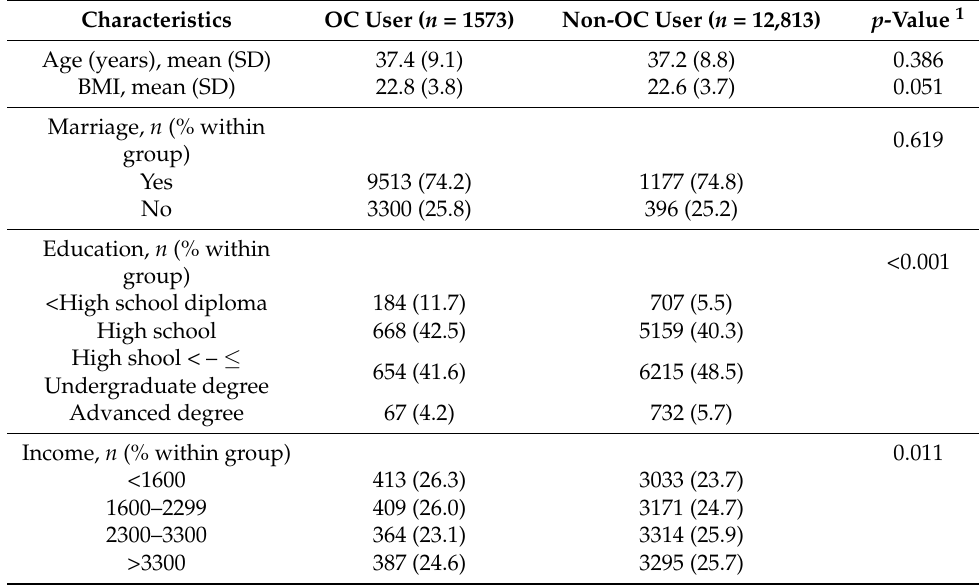
Table 2. Sociodemographic factors affecting oral contraceptive (OC) use among married Ko- rean